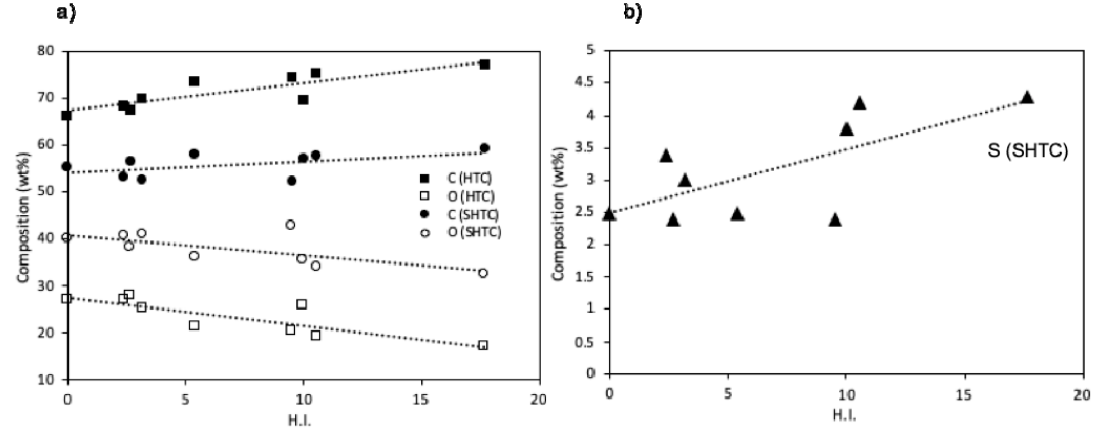
Figure 4. Relationship between hydrothermal index (H.I.) of HTC and composition of HTCs and SHTCs: ( a ) Carbon and oxygen content (wt%); ( b ) sulfur content (wt%).